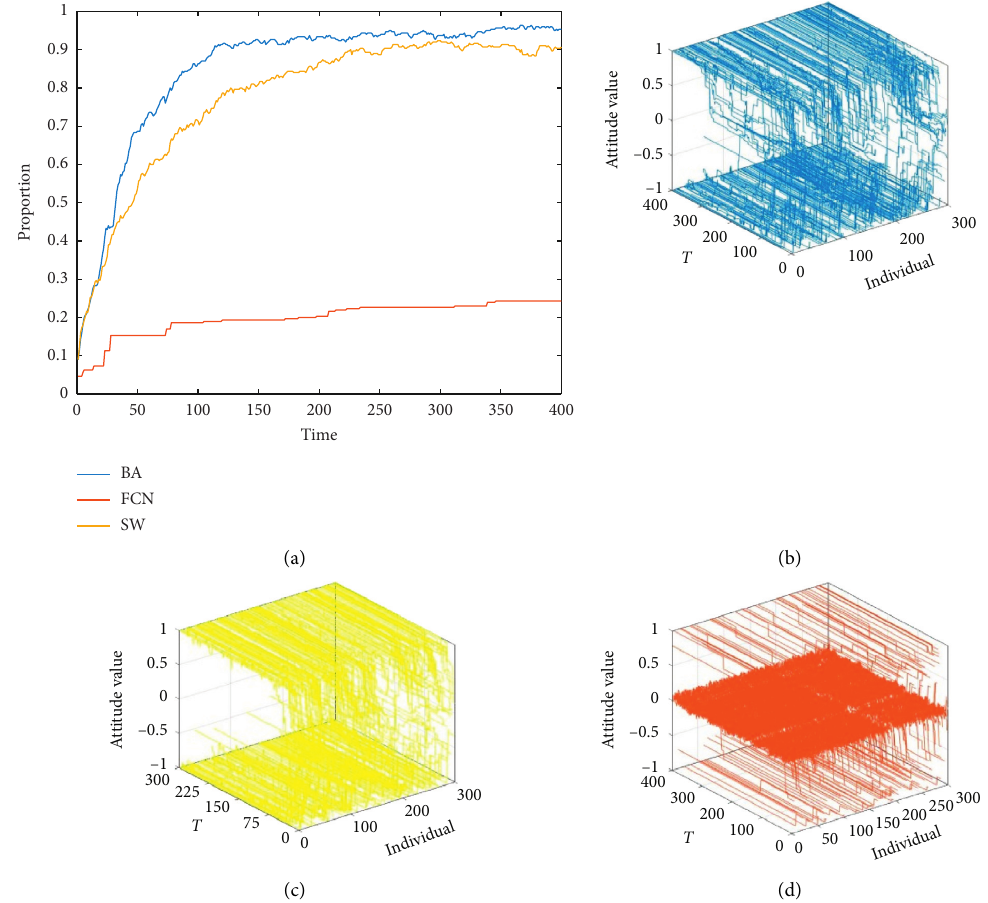
Figure 18: Comparison of attitude polarization process under different network structures ( p � 0 .